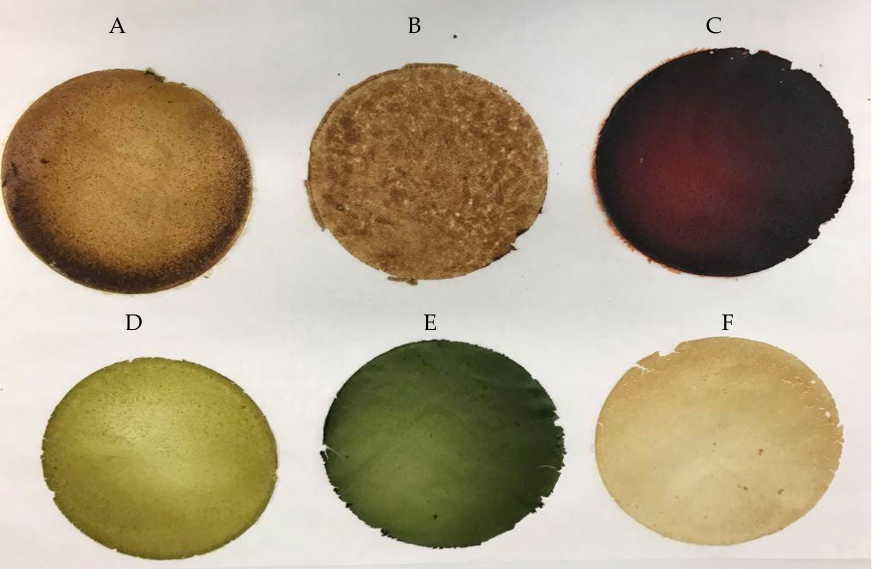
Figure 6. Edible films based on soy protein isolate and oilseed flours ( A —SPI_Hempseed; B — SPI_Flaxseed; C —SPI_ Evening_primroseseed; D —SPI_Pumpkinseed; E —SPI_Sunflowerseed; F — SPI_Sesameseed).